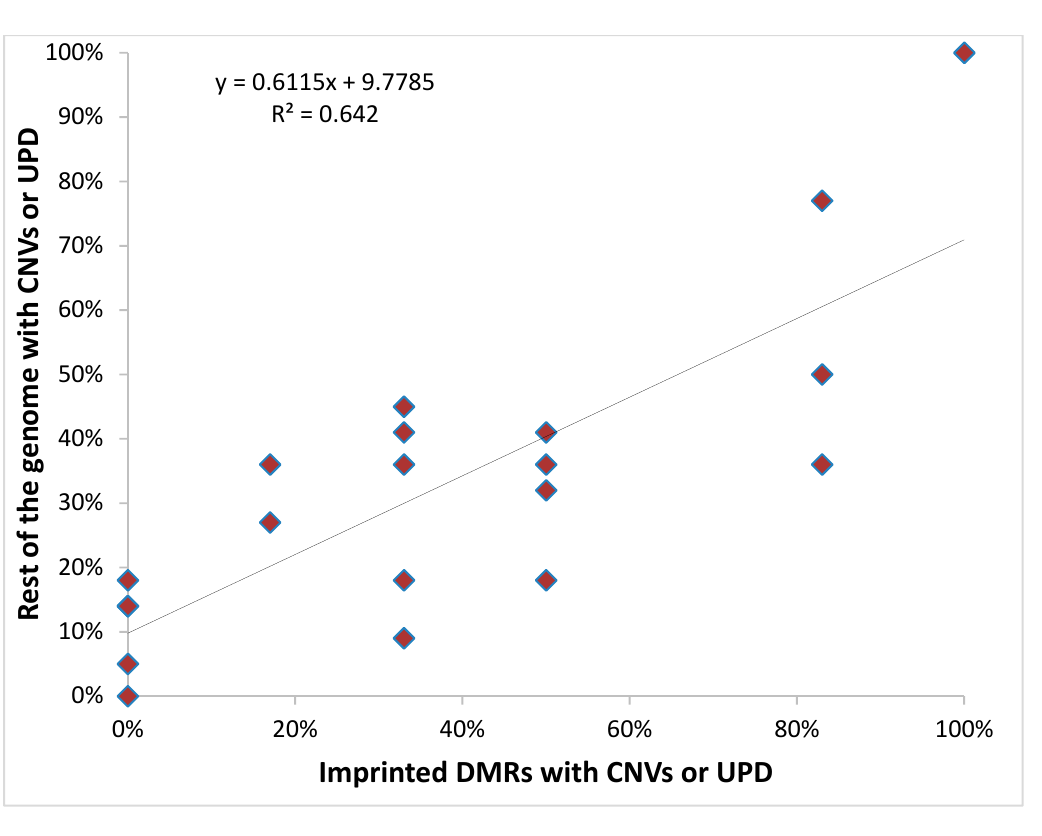
Figure 4. Correlation between chromosome aberrations of imprinted DMRs and the rest of the genome in WTs with methylation imprinting defects. Table 1. WTs driver genes flanking the indicated imprinted